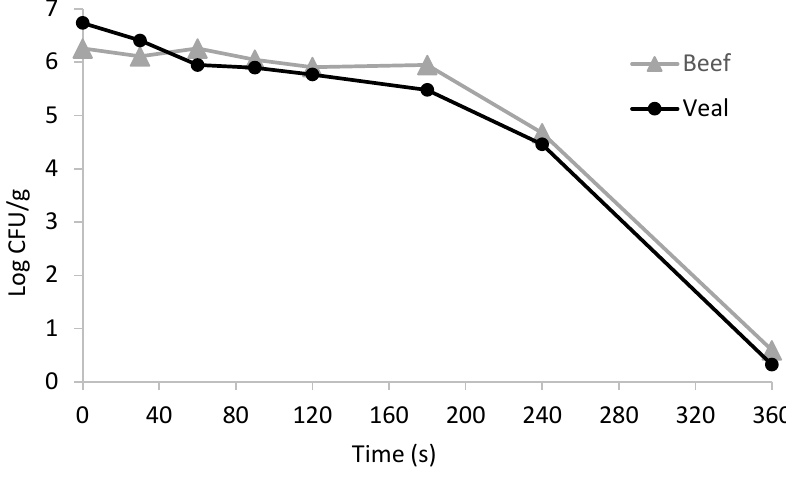
Figure 2. Survival curves of Escherichia coli O157:H7 in non-intact course ground beef and veal patties